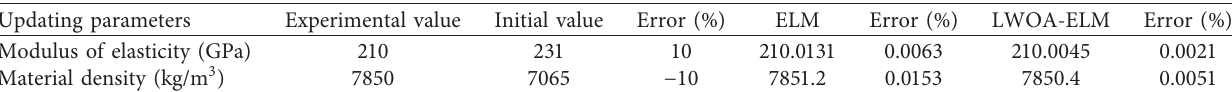
Figure 8: FRFs of initial FEM, experimental model, and updated model. (a) Values of the real part. (b) Values of the imaginary part. Table 4: Values and errors of the updated parameters without noise.